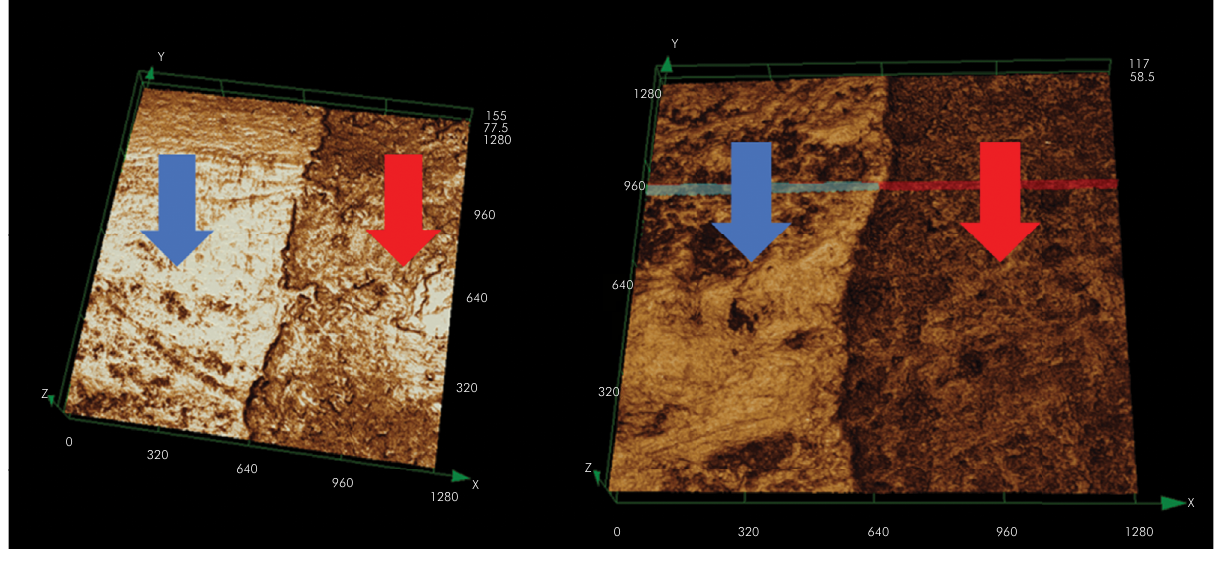
Figure 2. Representative images of specimens obtained by confocal laser scanning (× 20 magnification). The blue arrow indicates the control region (root dentin without exposure to preventive treatments and challenges) and the red arrow indicates the experimental region (exposed to preventive treatments and